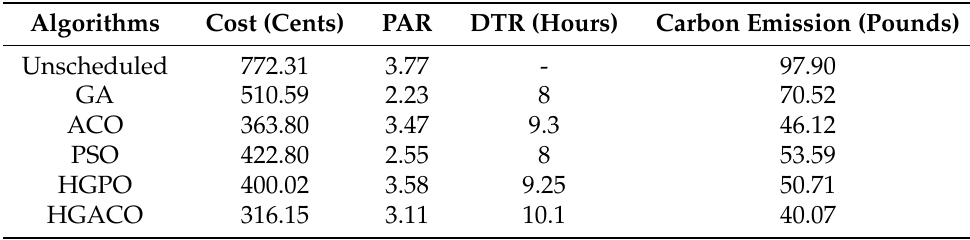
Table 17. Scenario III: performance tradeoff analysis of the proposed and existing algorithms with photovoltaic-battery